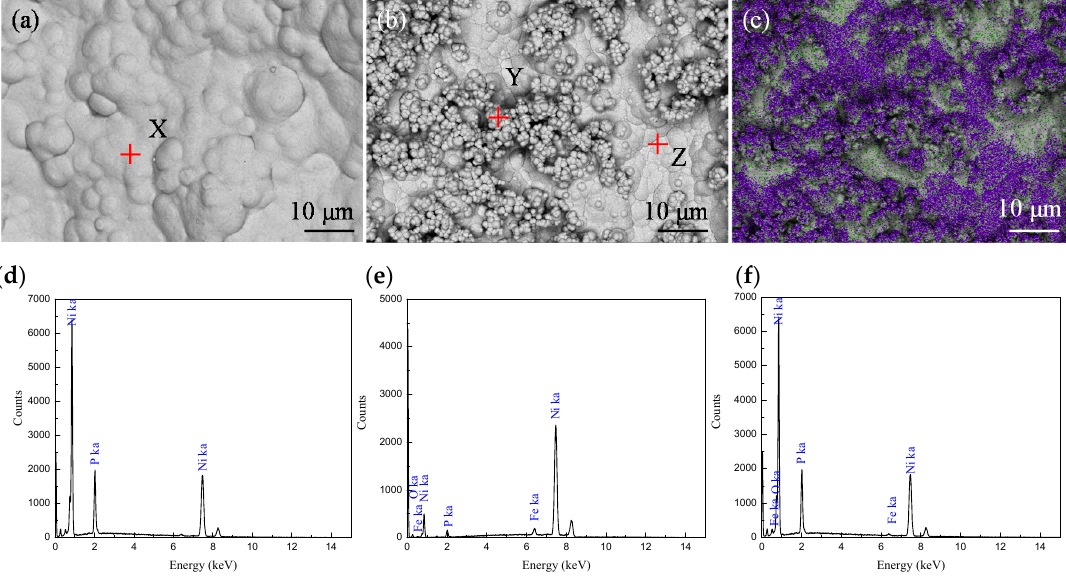
Figure 7. The SEM morphologies of the coating at ( a ) 70 °C and ( b ) 80 °C, EDS results of the coating, on X ( d ) and Y ( e ), Z ( f ), and mapping of elements of P in ( c ).